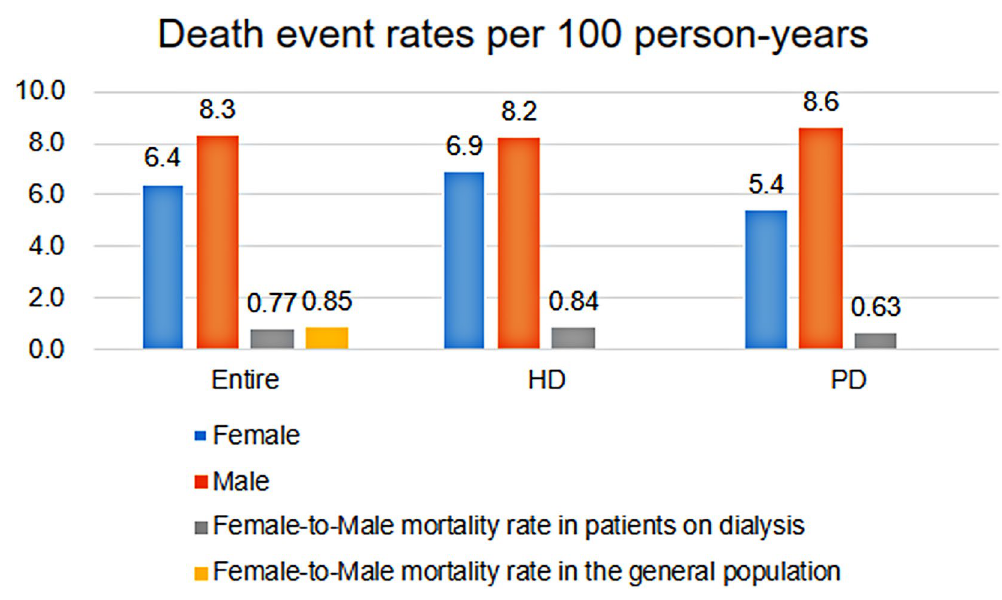
Figure 2. Death event rates per 100 person-years in male and female patients according to dialysis modality. The rate was 6.4 in females and 8.3 in males in the entire population, 6.9 in females and 8.2 in males in the hemodialysis (HD) population, and 5.4 in females and 8.6 in males in the peritoneal dialysis (PD) population.